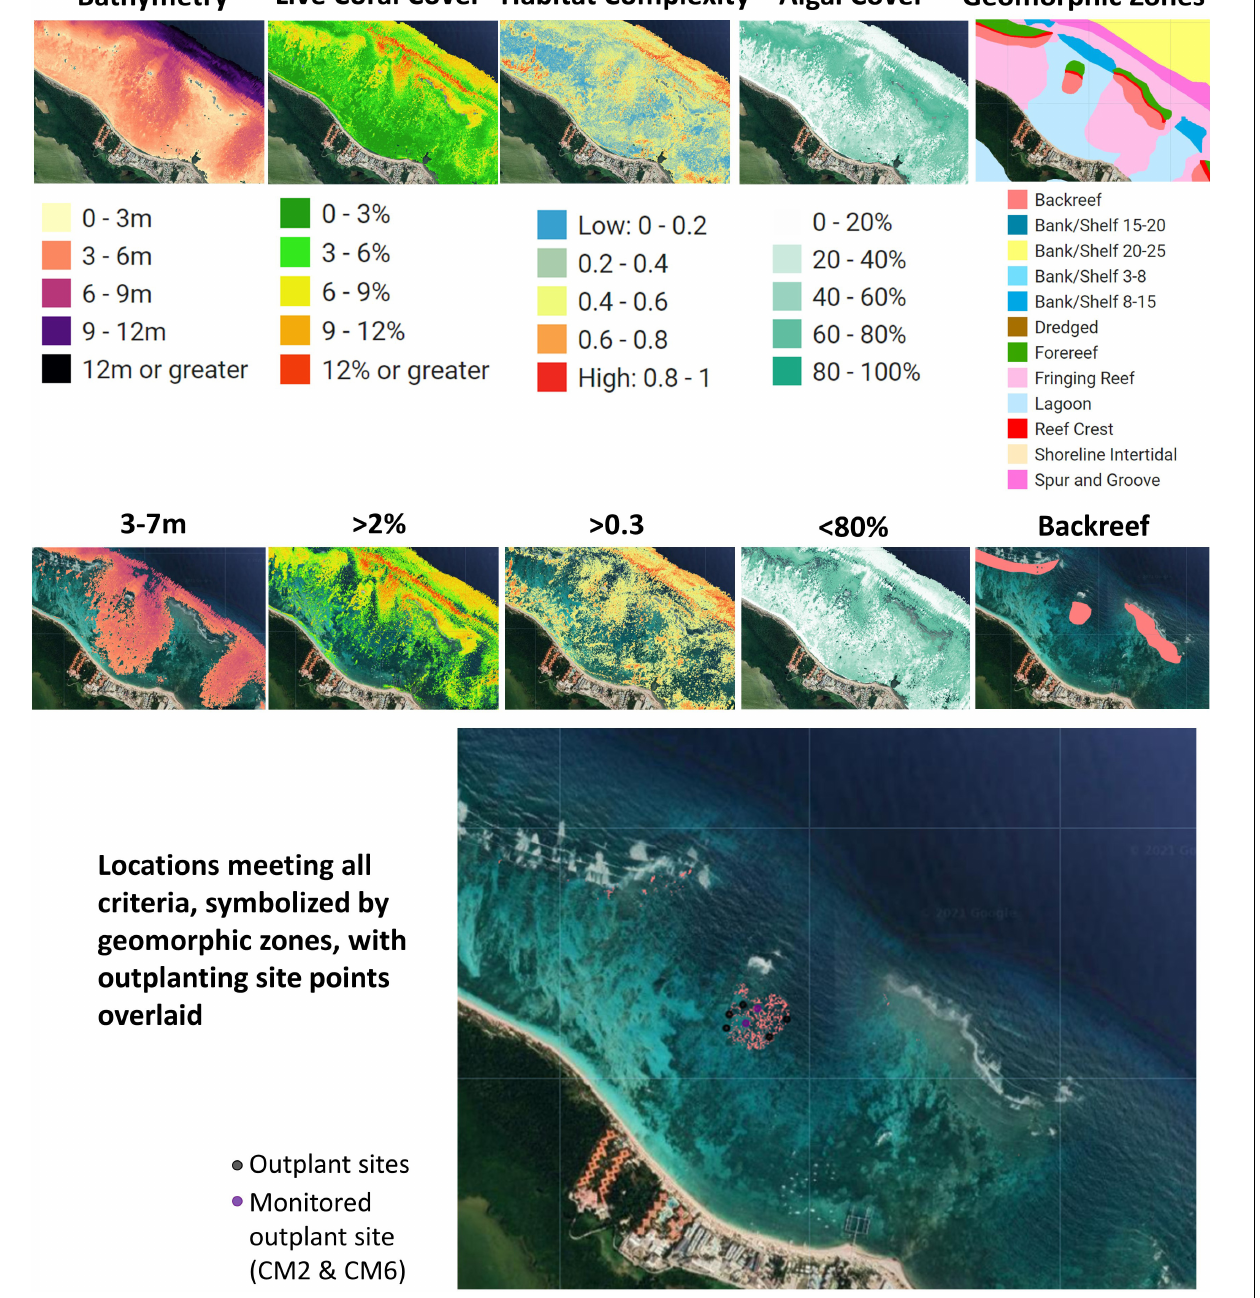
FIGURE 3 | Data layers and criteria used to select suitable outplant sites in Bávaro, Dominican Republic. Sites were identified using the Coral Outplanting Siting Guide Google Earth Engine (GEE) app and used as the focal restoration area in the community-led outplanting activity. These criteria were based on key ecological factors of Acropora cervicornis that would promote the likelihood of outplant